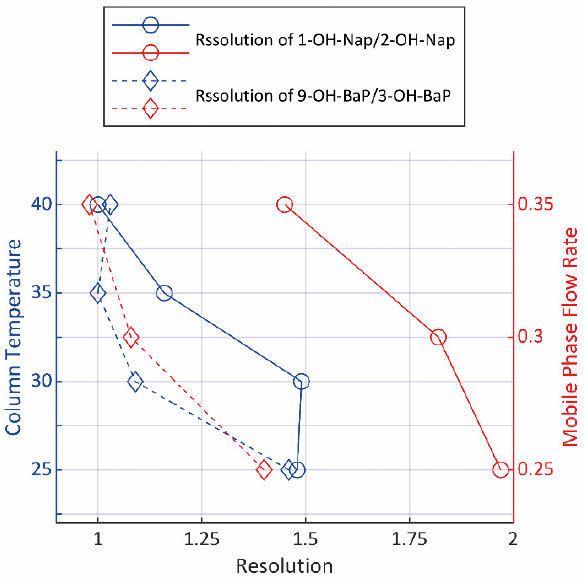
Figure 3. The resolution of isomers under different LC parameters.